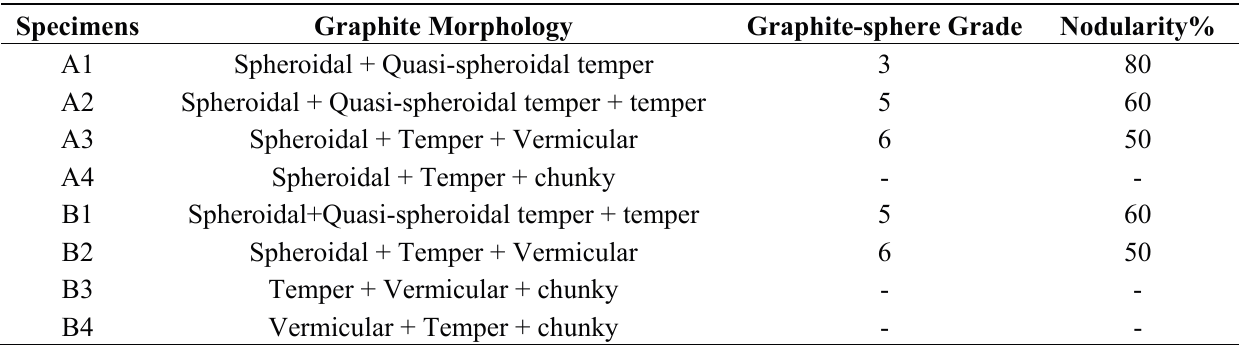
Table 3. Morphology of graphite, graphite sphere grade and nodularity in Casting-A (Si content = 1.78 wt.%) and Casting-B (Si content = 2.74 wt.%). Specimens Graphite Morphology Graphite-sphere